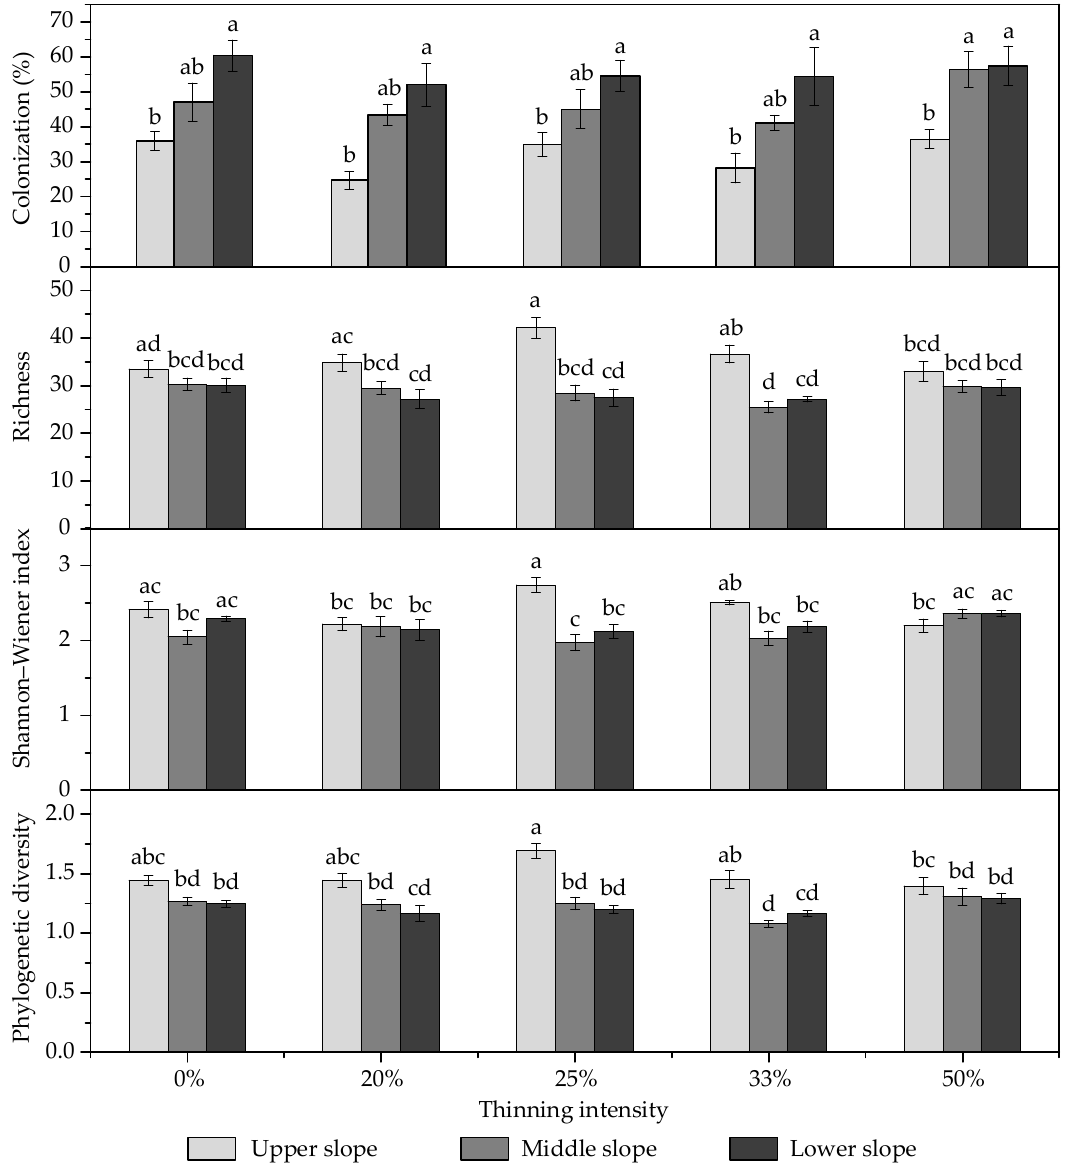
Figure 3. Differences of AMF colonization, richness, and diversity among slope positions and Figure 3. Di ff erences of AMF colonization, richness, and diversity among slope positions and thinning thinning intensities. Values are means ± standard errors. Different letters indicate significant intensities. Values are means ± standard errors. Di ff erent letters indicate significant interactions or interactions or slope position main effects ( p ˂ 0.05) based on a two-way ANOVA followed by a slope position main e ff ects ( p < 0.05) based on a two-way ANOVA followed by a Tukey’s HSD multiple Tukey’s HSD multiple comparison test. comparison